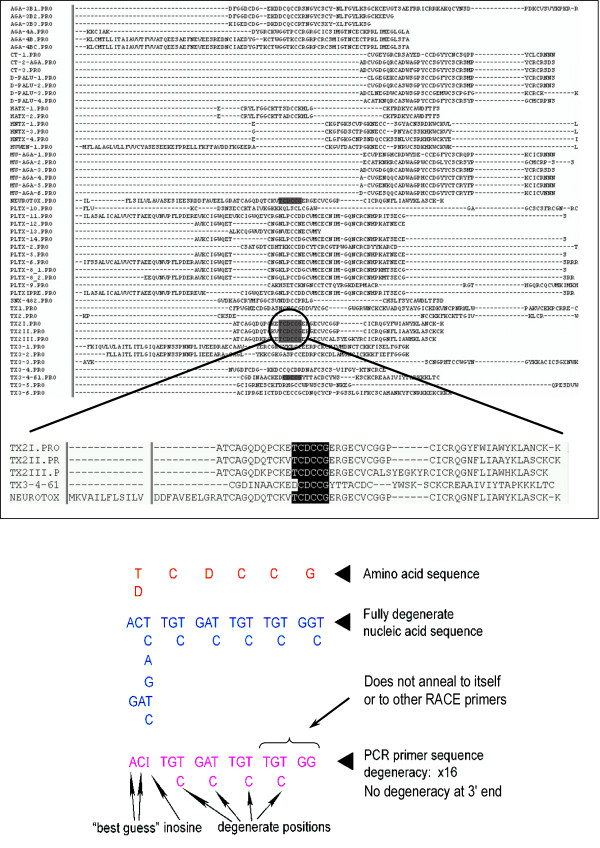
Multialignment of the protein toxin sequences obtained form Genbank and SwissProt. Over 150 toxin and toxin-like sequences were available in the beginning of investigation and were aligned to identify potential conservative sequence motifs. 51 sequences shown aligned (top panel). The five sequences (TX2I, TX2II, TX2III, TX3-4-61 and NEUROTOX from Phoneutria nigriventer (Brazilian armed spider)) selected to exemplify a conservative motif "T/DCDCCG". Bottom panel exemplifies the strategy of primer design.